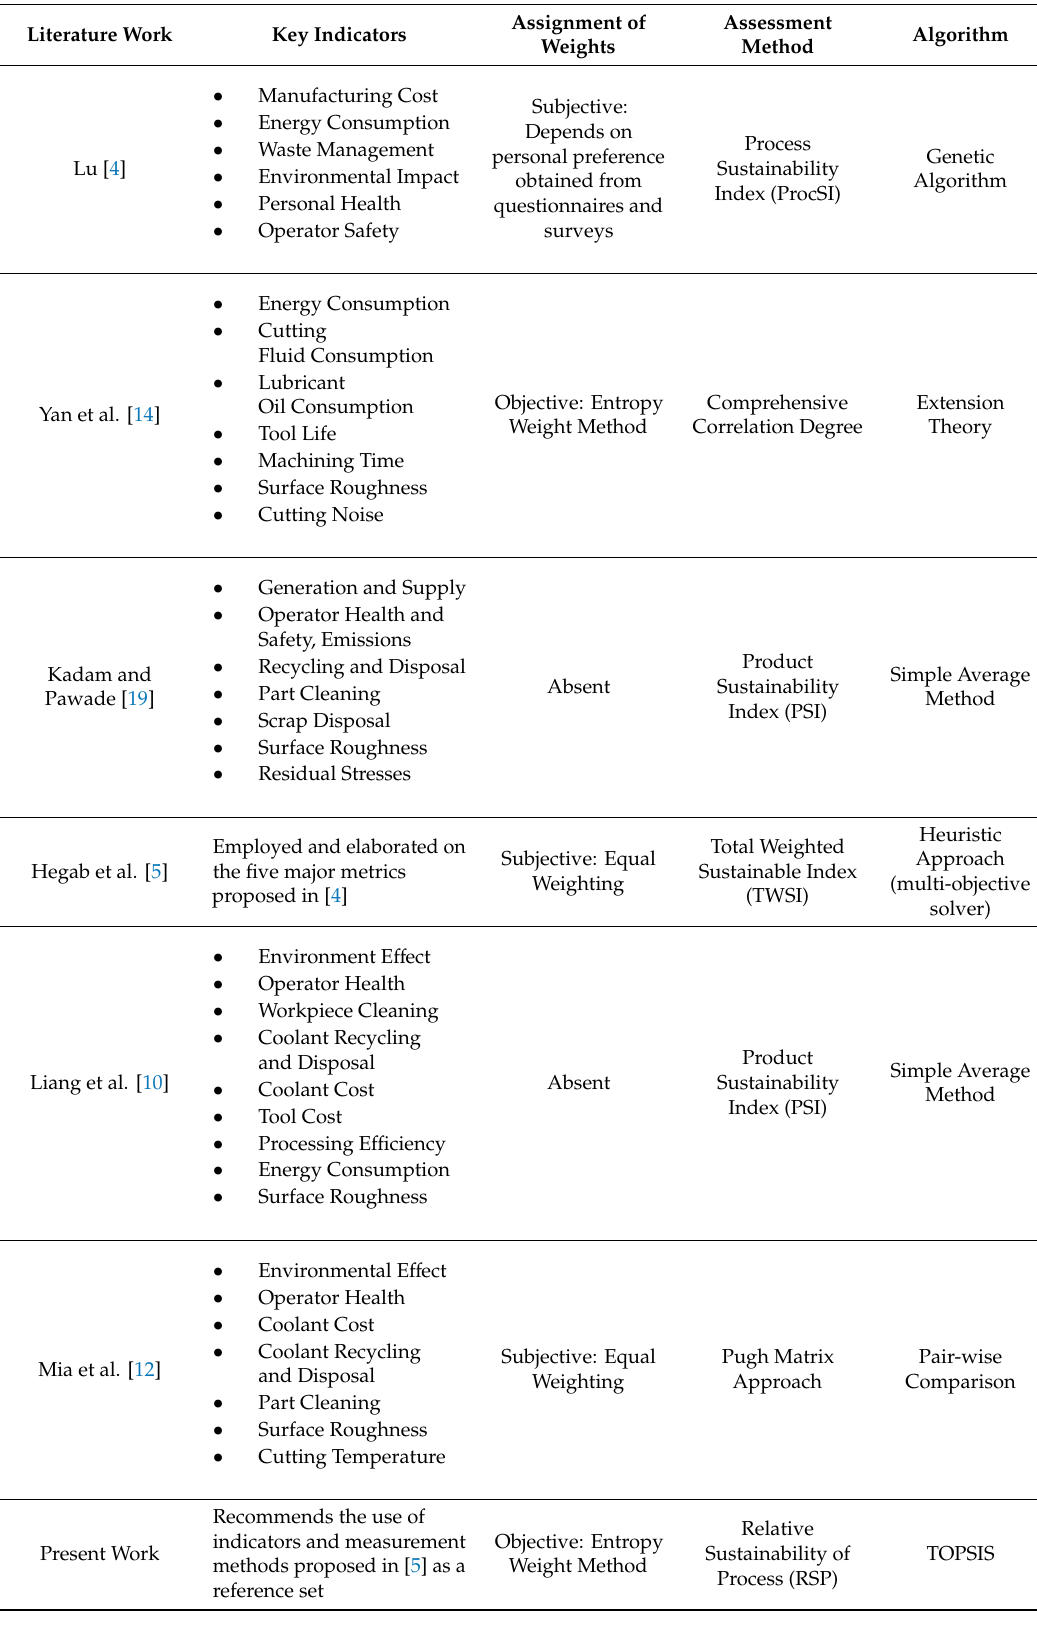
Table 1. A comparison between the assessment frameworks proposed in the